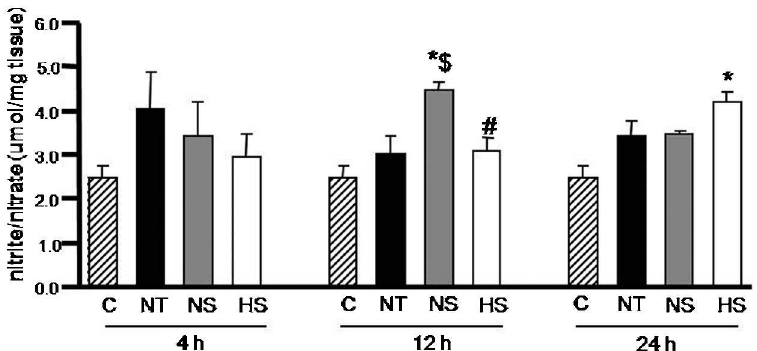
Figure 2 - Nitrite and nitrate levels determined by the Griess reaction in liver homogenates of rats in the control (C), NS, HS, and NT groups. Data are means ¡ SEM, n = 5 in each group. * P , 0.01 vs. C; $ P , 0.05 vs. NT; # P , 0.05 vs.